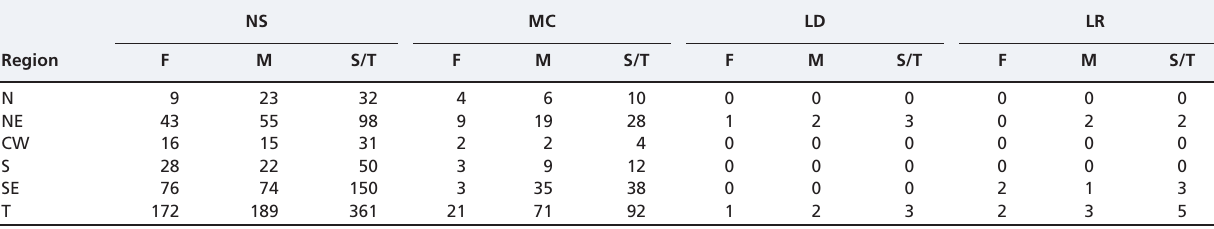
Table 7 - Geographic distribution of CHL morphologic subtypes.*